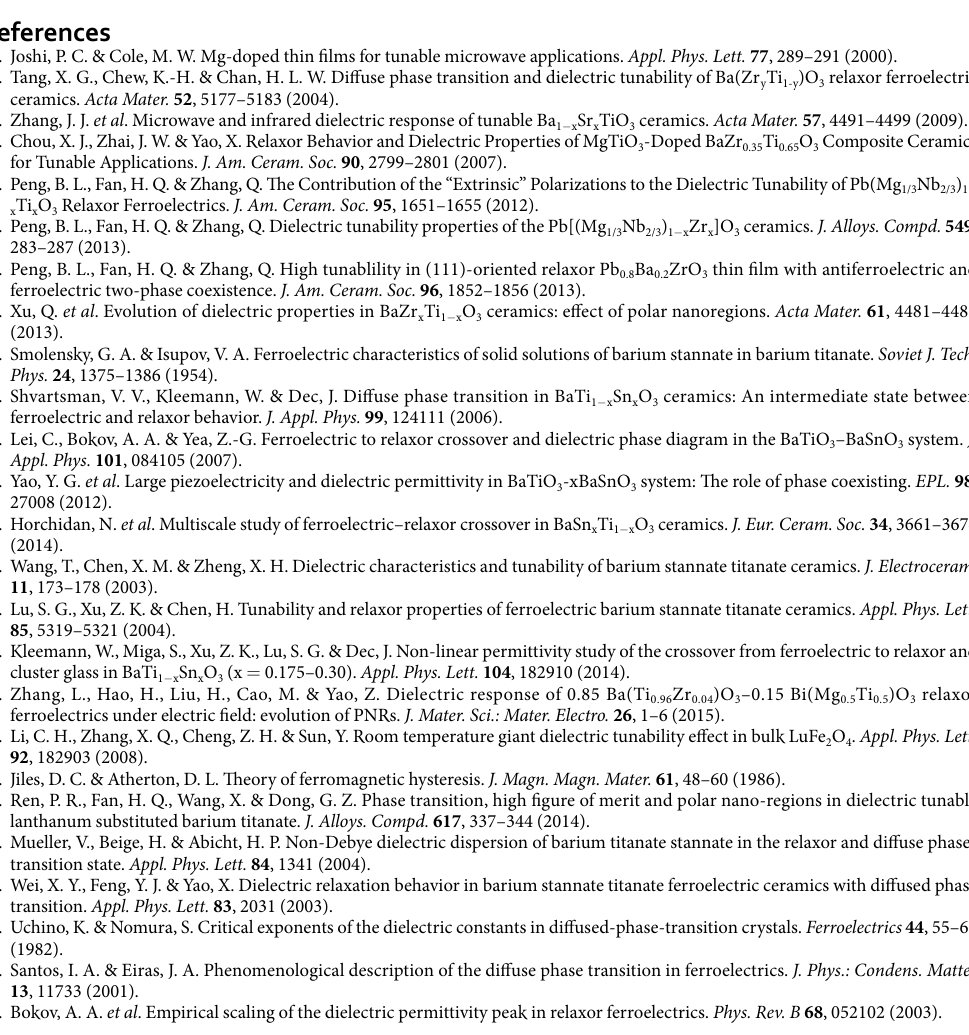
found to have the maximum tunability at the room temperature, which is up to 90.5%. The nonlinear dielectric behavior of BTSn ceramics was analyzed by the multipolarization-mechanism model. The enhanced dielectric tunability is attributed to the presence of mico-domains that coexist with polar nanoregions. This work could provide new insights into the nonlinear dielectric behavior of Pb-free dielectrics.